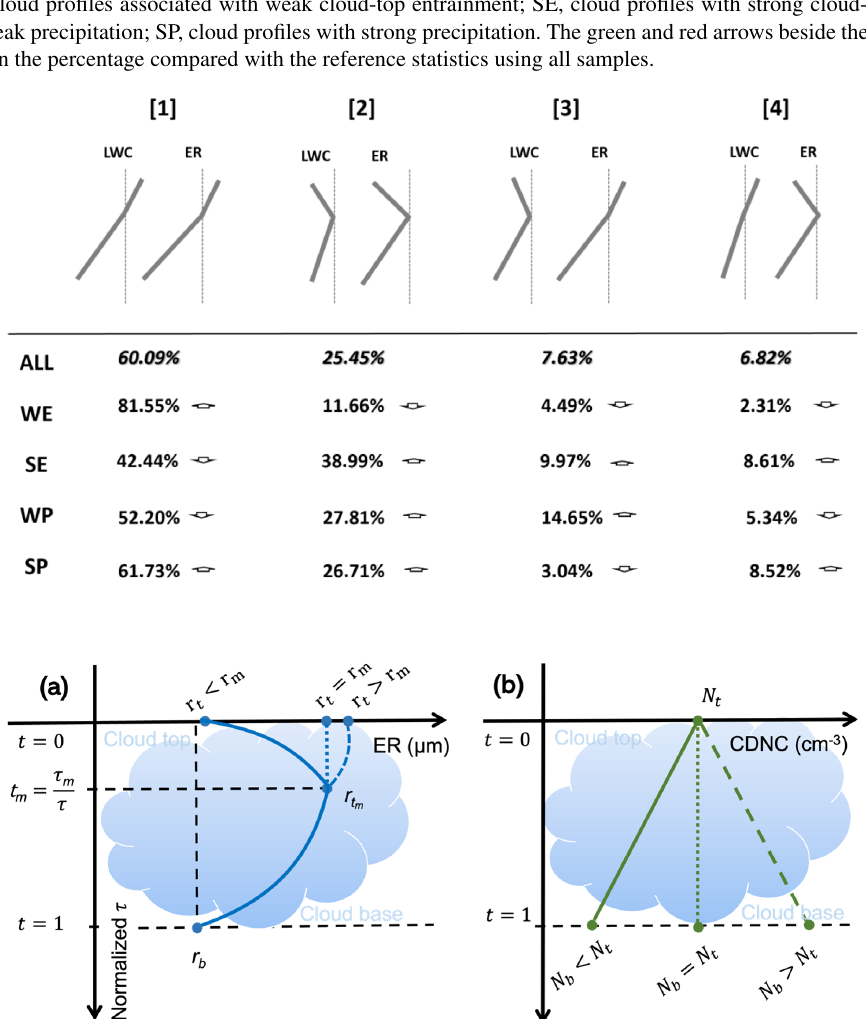
Figure 9. (a) Simplified triangle-shaped profiles for the cloud ER and (b) simplified linear profiles for CDNC (N). Both τ or normalized optical thickness ( t ) axes can be used to define the top ( τ = t = 0), turning point ( τ = τ m ,t = τ m profile. r b , r m , and r t are the effective radii at the cloud base, the turning point, and cloud top, respectively. The N profile is based on a linear assumption with a slope. The stratified values for the ER and LWC profiles are calculated using the parameterization scheme presented in Sect.